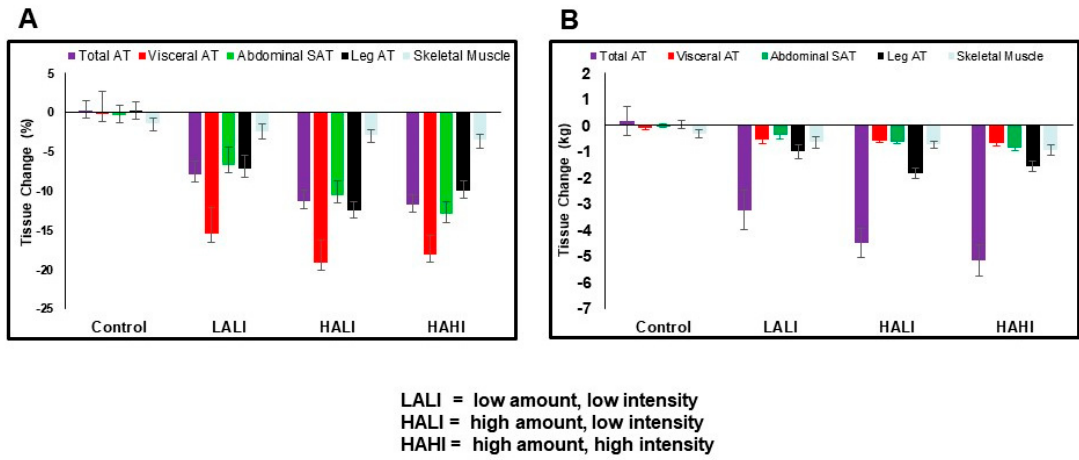
Figure 1. Illustration of relative (%, Panel A ) and absolute (kg, Panel B ) response of adipose and skeletal muscle tissues to variations in exercise dose. Taken from Reference [14]. Used with permission from Obesity. Absolute (left) and relative (right) changes in AT and skeletal muscle depots. With the exception of skeletal muscle, all AT depot changes (absolute and relative) were significantly different from control ( p < 0.008; both panels). Relative change in VAT was greater than all other AT and skeletal muscle depots ( p < 0.01; right panel). AT, adipose tissue; HAHI, high amount, high intensity; HALI, high amount, low intensity; LALI, low amount, low intensity.